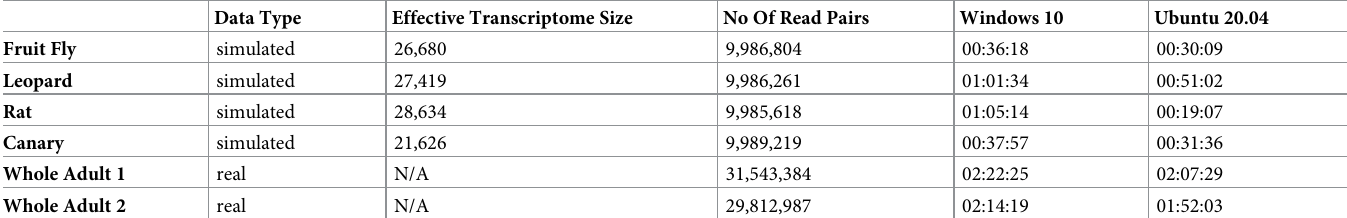
Table 2. Running times. Times, in hours, minutes and seconds, taken by CStone to assemble datasets used in this study on Windows 10 running on 32 cores (AMD Ryzen Threadripper 2990WX @ 3.00GHz) and 128GB of ram, as well as on Ubuntu 20.04 running on 24 cores (Intel Xeon(R) CPU E5-2697 v2 @ 2.70GHz) and 64GB of ram. For simulated datasets “Effective transcriptome size” refers to the cDNA reference transcripts from which the reads were simulated, whilst for real data it is the (unknown) number of expressed genes within the adults that were sequenced. Data